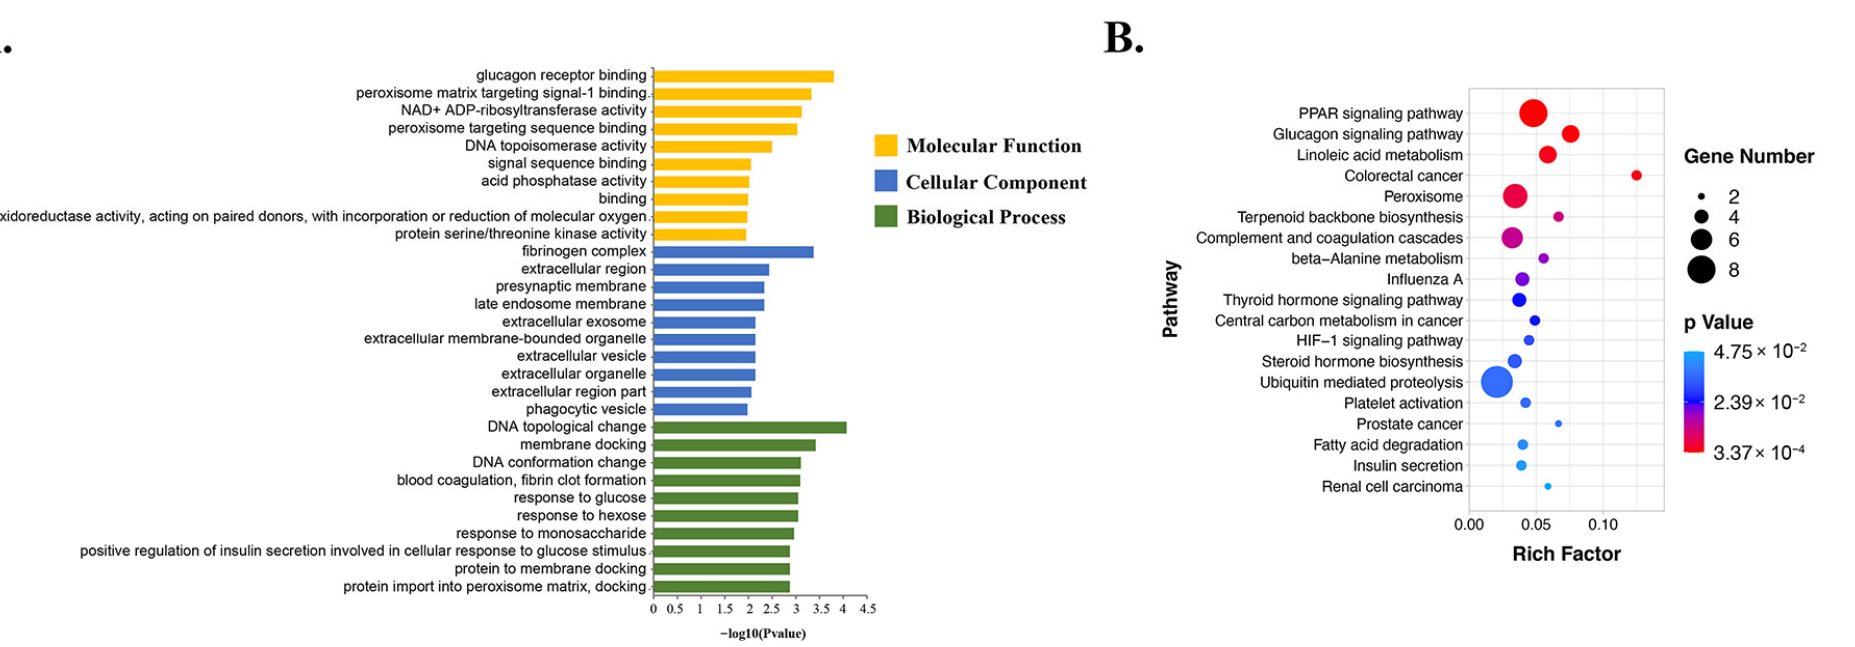
Figure 4. GO and KEGG enrichment analysis of DE-mRNAs in the liver of the HFD group compared with the NFD group. ( A ) Top 10 GO terms in three categories: biological process, molecular function, and cellular component. ( B ) Top 20 enriched KEGG pathways.